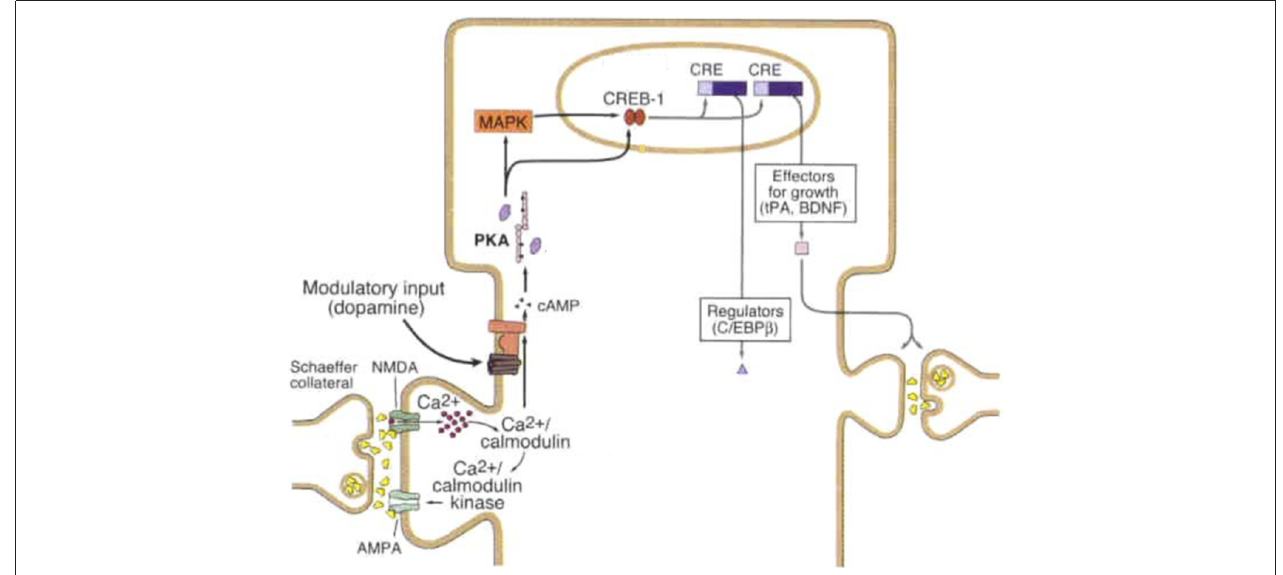
FIGURE 1 | Late-long-term potentiation (L-LTP) mechanism at Schaeffer collateral synapse. Strong synaptic stimulation results in high magnitude calcium (Ca 2 + ) influx, binding of calcium to calcium calmodulin which subsequently binds to calcium/calmodulin kinase and activates adenylyl cyclase (AC). AC generates the second messenger cyclic adenosine mono-phosphate (cAMP), cAMP activates PKA which translocates to the nucleus and activates mitogen activated protein kinase (MAPK) both of which turn on the transcriptional activator cAMP responsive element binding protein-1 (CREB-1). Upon CREB-1 binding to CRE transcription produces synapse modifying gene products including regulatory and growth proteins. Modulatory input, shown here as dopaminergic, can facilitate activation of AC and subsequent synaptic strengthening. Figure modified from Kandel (2001) License number